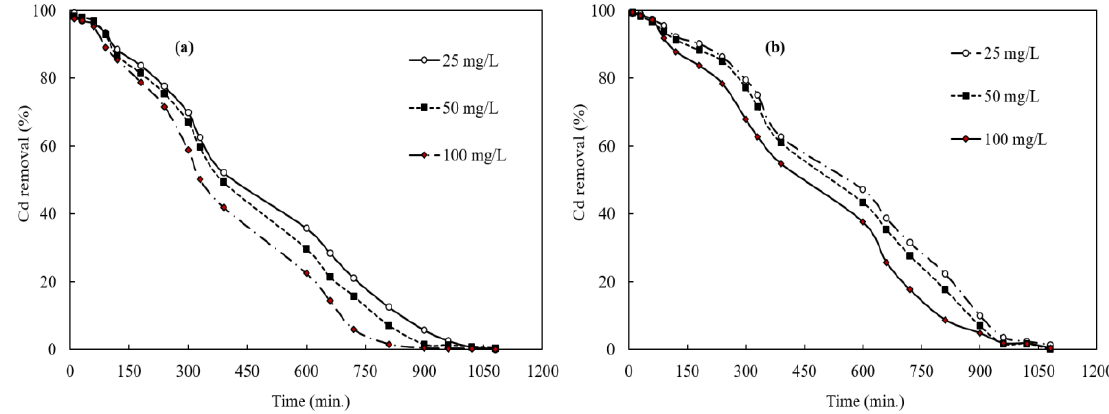
Figure 5. Removal of Cd at laboratory scale column experiments by WSB ( a ) and with AWSB ( b ) having different initial concentrations of Cd (25, 50 and 100 mg/L) in response to WSB and AWSB dose (5 g/column).